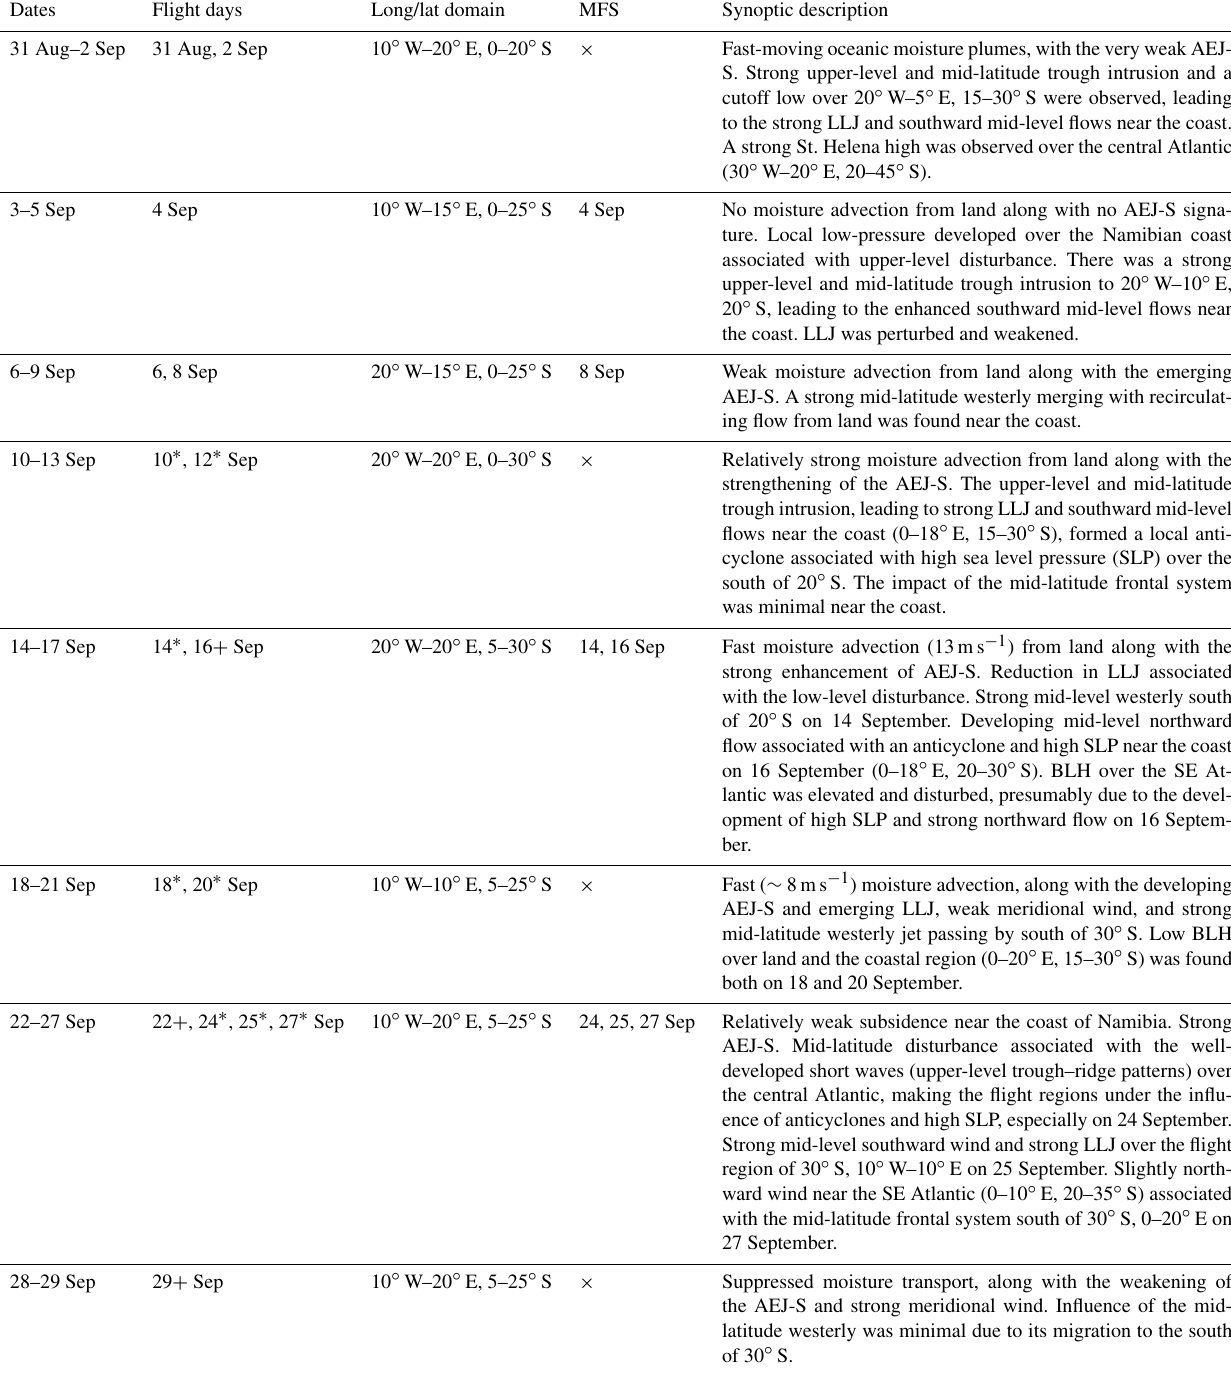
Table 1. Characteristics of synoptic-scale features over SE Atlantic during the September 2016 deployment. The asterisk ( ∗ ) represents that both P-3 and ER-2 flights were available, while the plus ( + ) sign represents that only the ER-2 flight was available. No notation indicates that only the P-3 flight was available. MFS represents the mid-latitude frontal system affecting the flight region on that day (whereas the × sign represents no